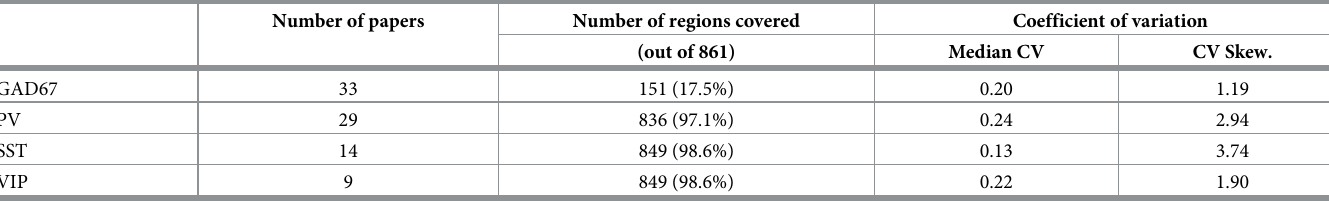
Table 1. Summary of papers reviewed by marker.